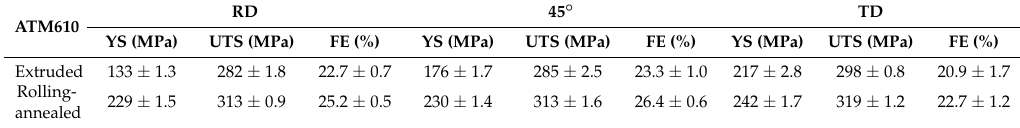
Table 1. Tensile properties of ATM610 alloy sheets at room temperature in different loading